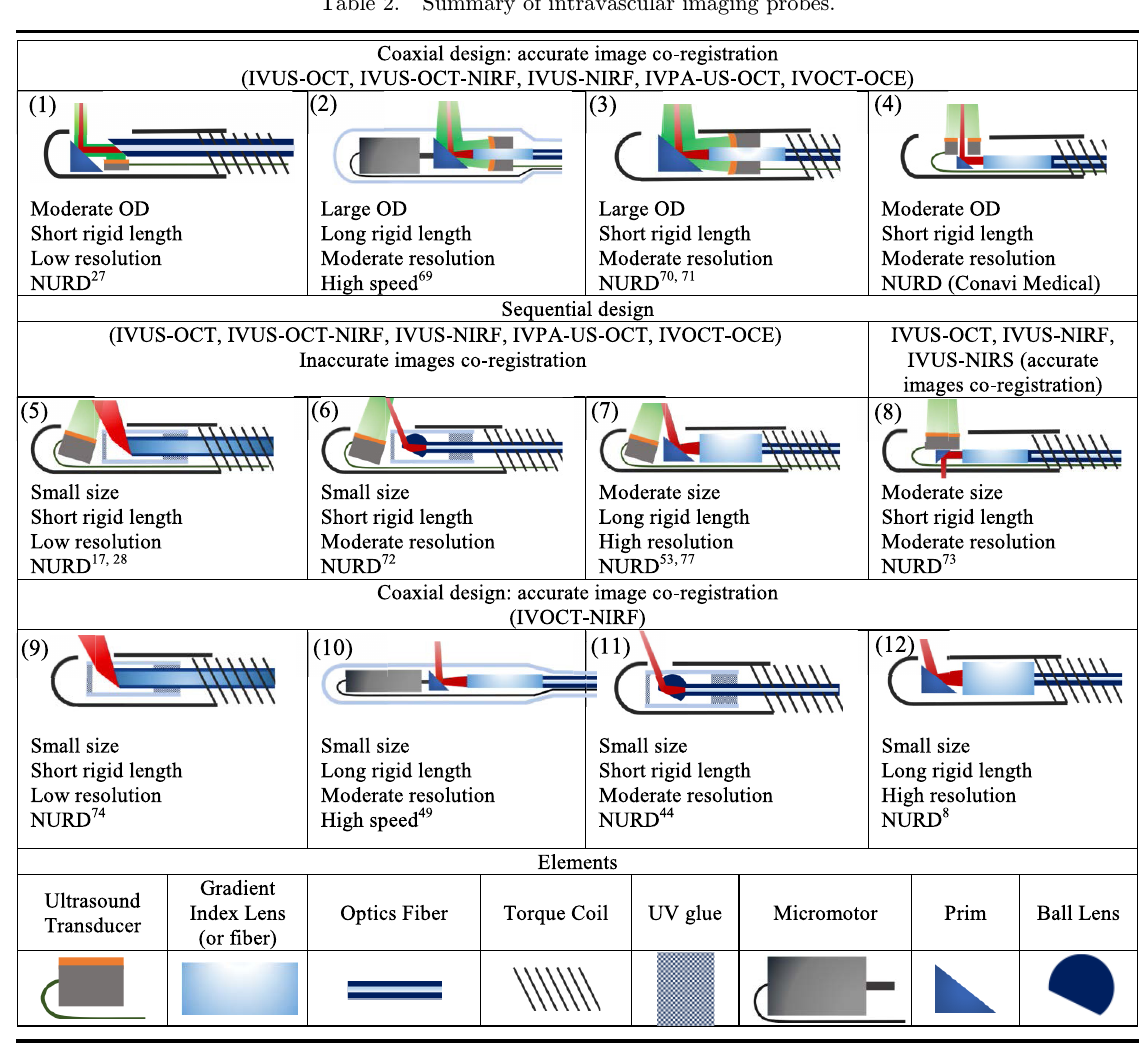
Table 2. Summary of intravascular imaging